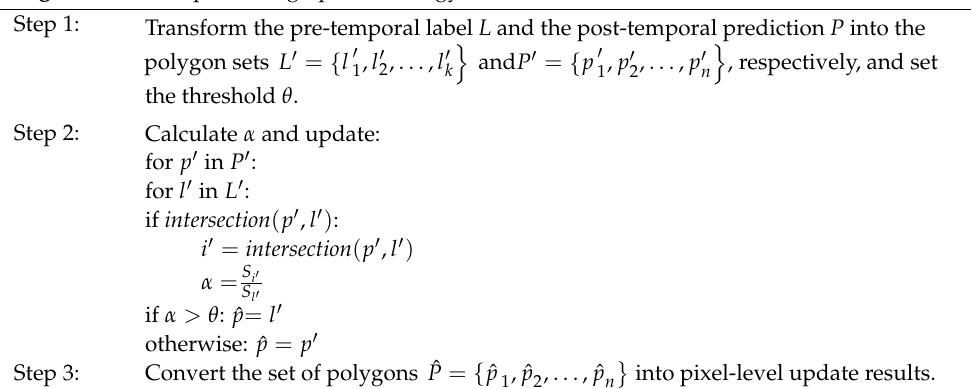
Algorithm 1 Post-processing update strategy